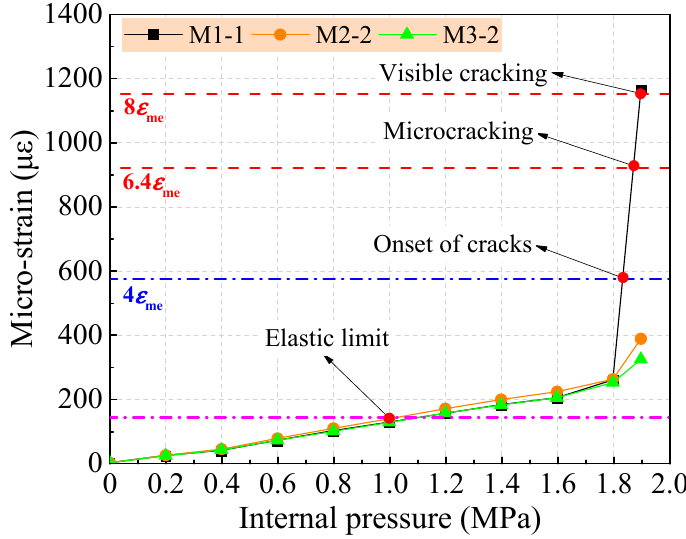
Figure 14. Control strain of mortar at each